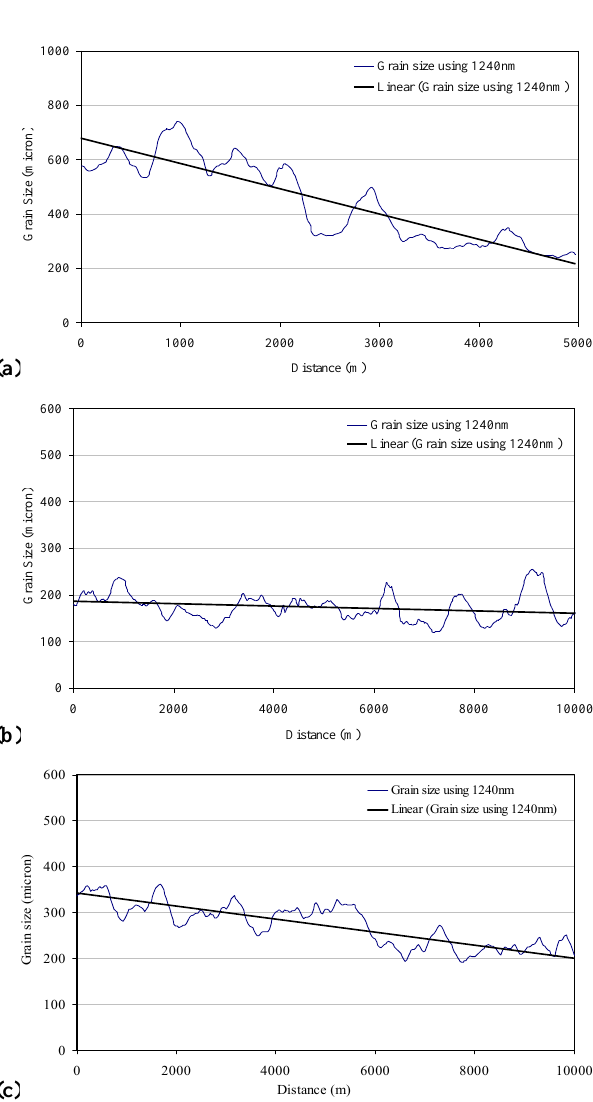
(Kokhanovsky and Zege, 2004). The modeled albedo can be observed well in agreement in NIR region for both the sta- tions, where the albedo is controlled by grain size. But for the visible region it can approximately work well in case of only pure snow, as the visible albedo changes significantly by slight contamination in snow. Therefore, we feel retrieval of spectral albedo using satellite reflectances at visible and NIR channels has more advantage in describing the snow cover